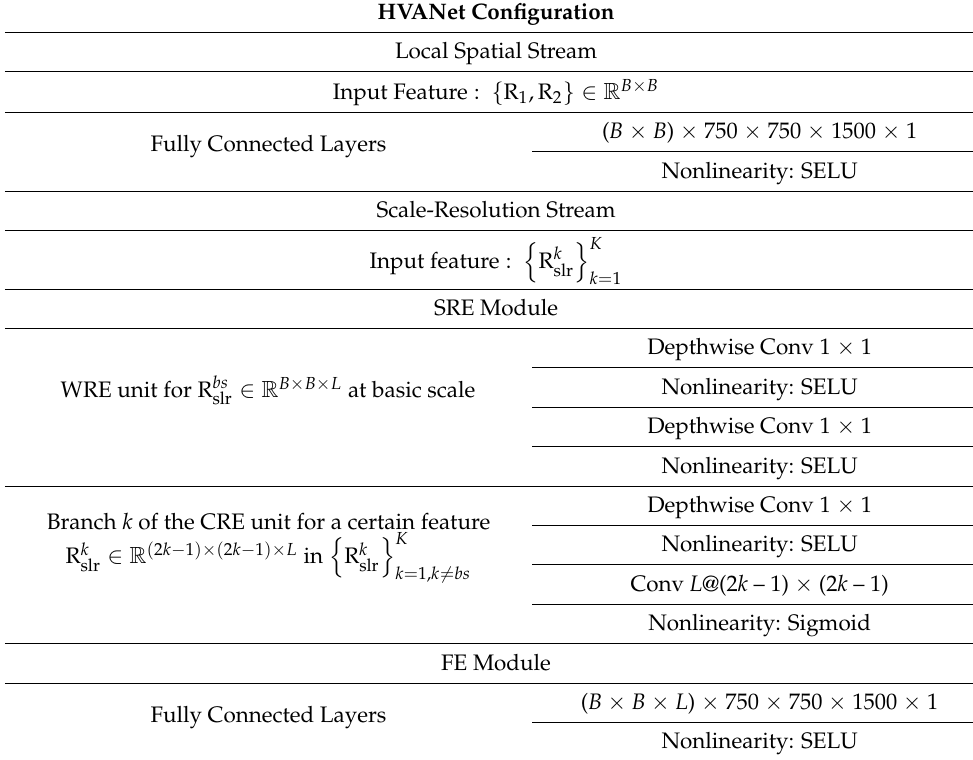
Table 1. Architecture of the proposed